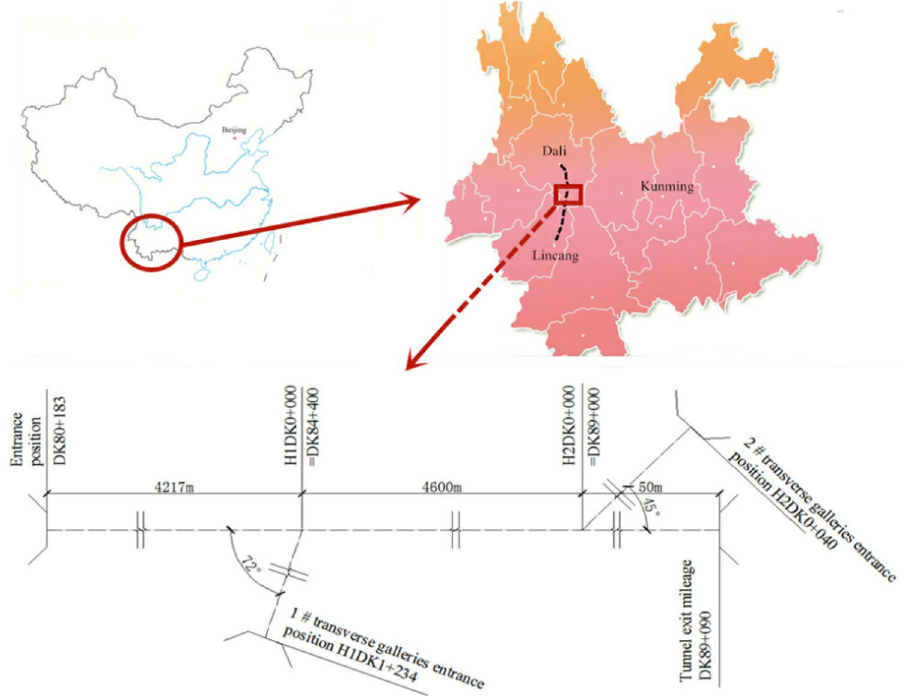
Figure 1. Location and layout of the Xingzishan